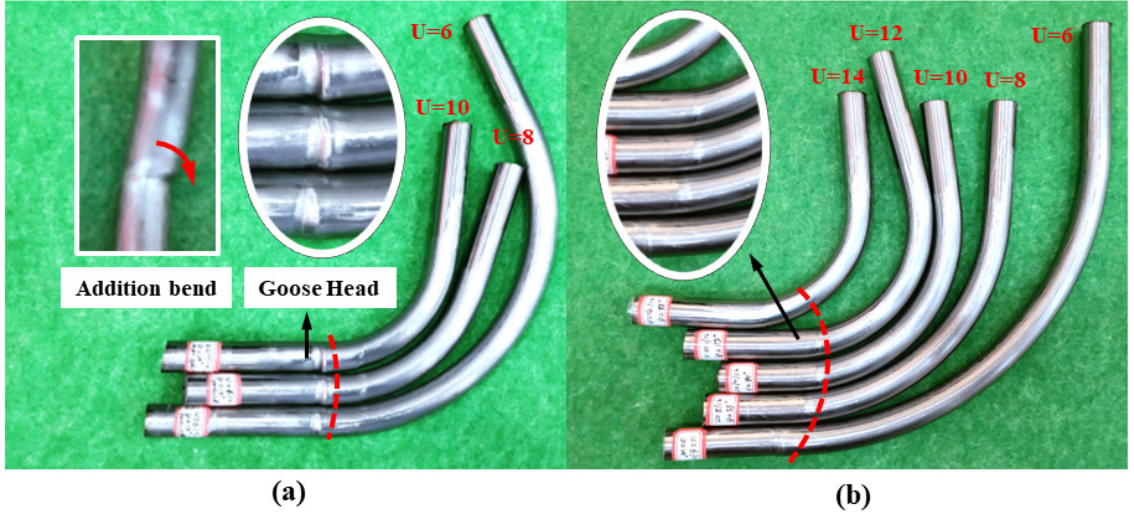
Figure 15. Experimental results of active deflection: ( a ) rounded corner transition structure; ( b ) bell- shaped transition structure.